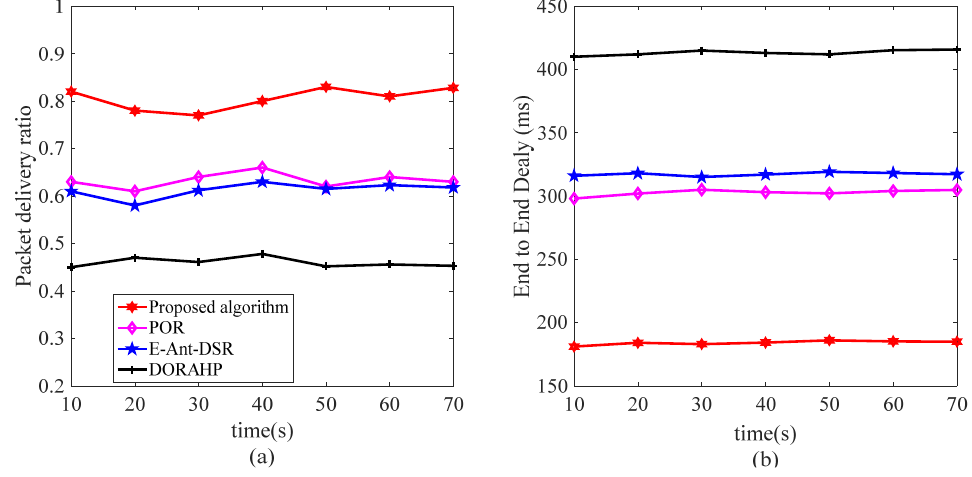
Figure 5. ( a ) Comparison of packet delivery ratio. ( b ) Comparison of end-to-end delay.